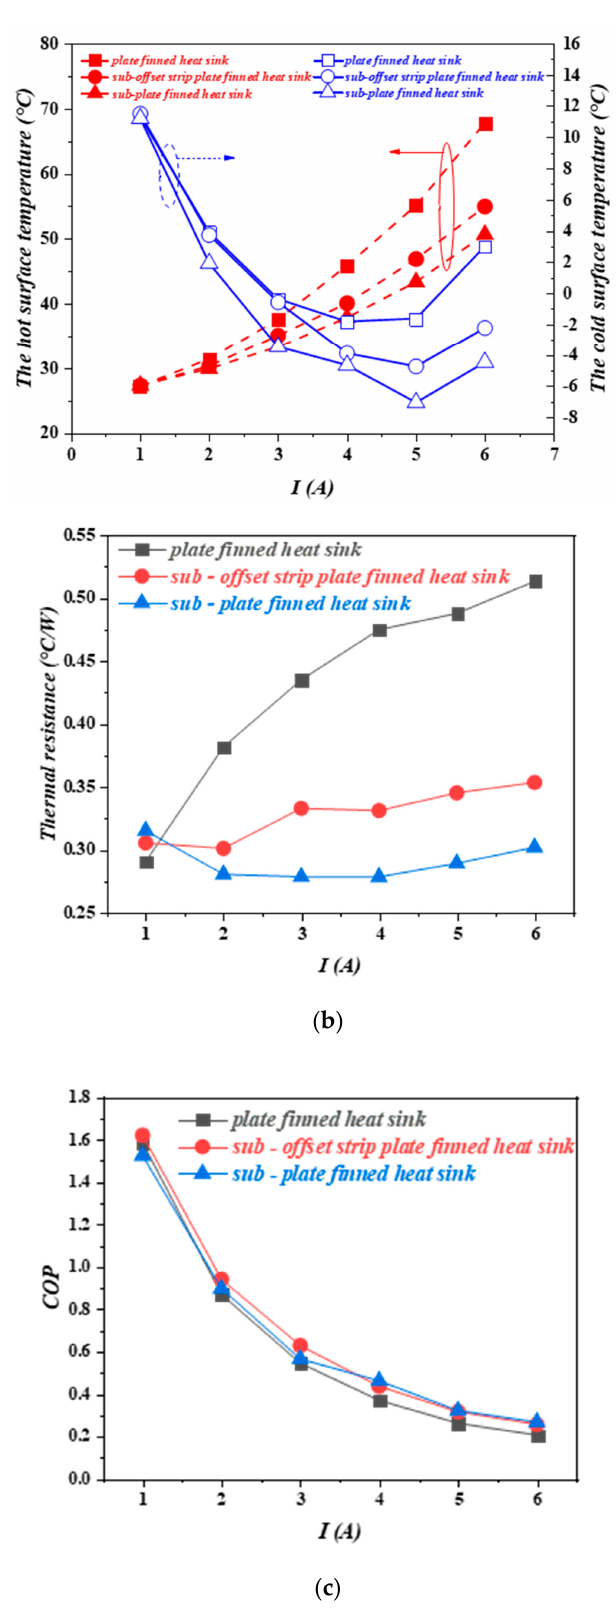
Figure 5. Comparison of heat sink performance under different input current, ( a ) the hot and cold surface temperature, ( b ) thermal resistance of hot side, ( c ) COP. ( U out = 7.5